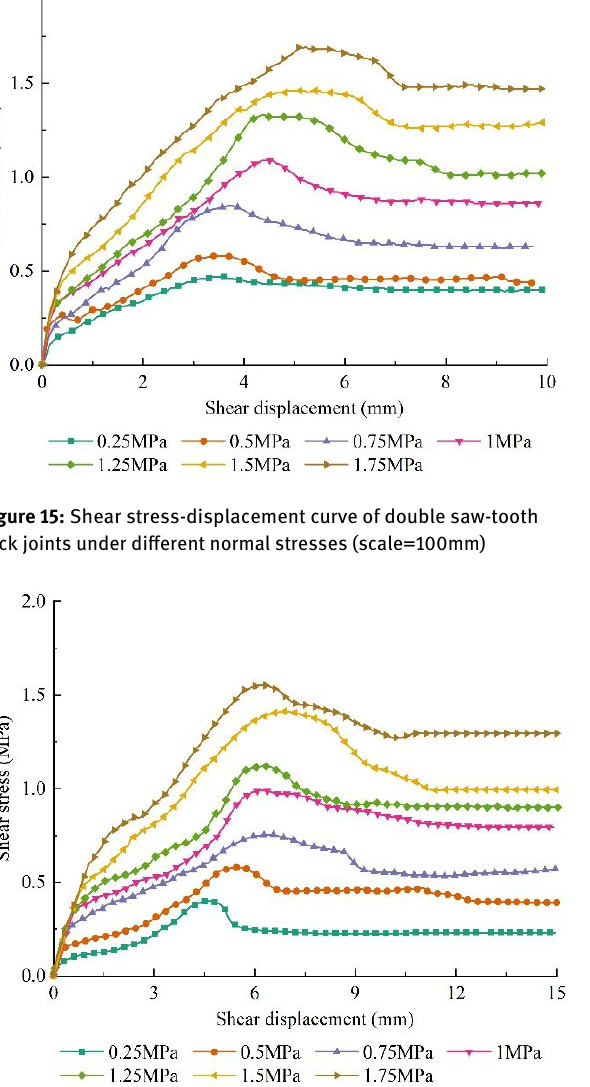
Figure 16: Shear stress-displacement curve of double saw-tooth rock joints under different normal stresses (scale=200mm)